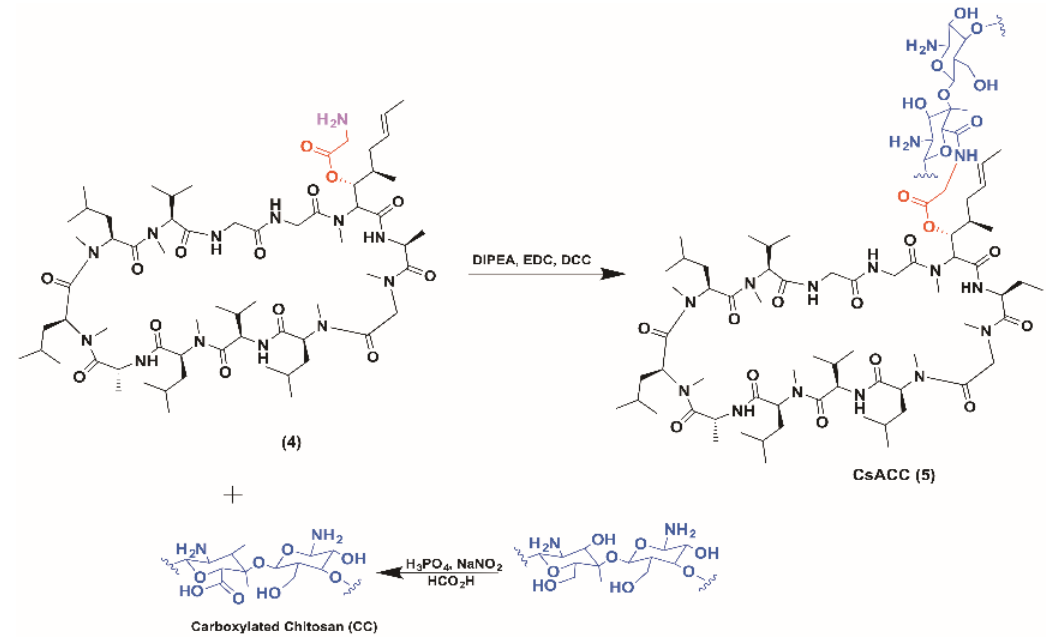
Figure 1. Scheme of CsACC synthesis.